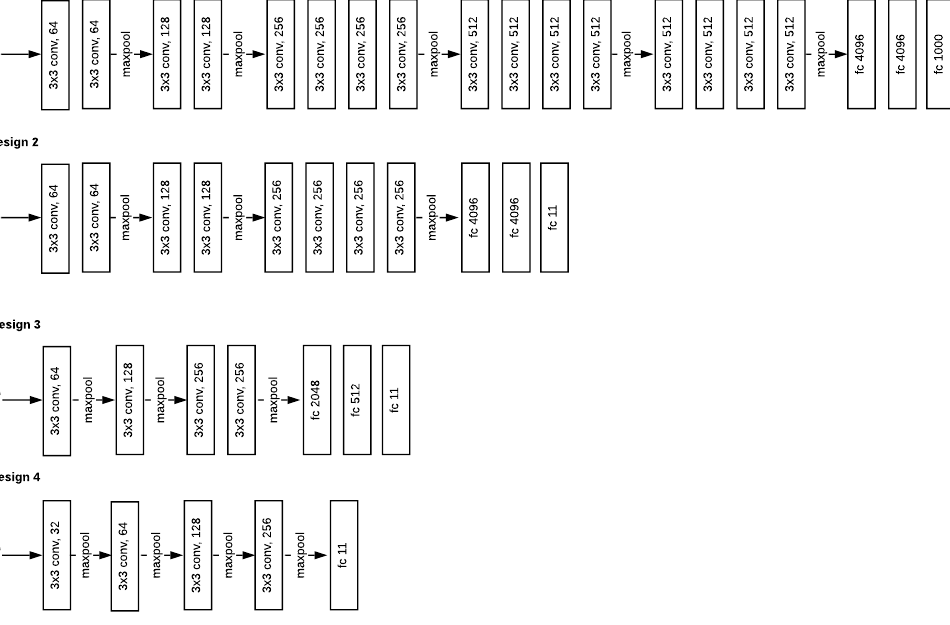
Figure A2. The evolution of spectrogram model architecture from VGG-19 architecture (Design 1) to the final model architecture (Design